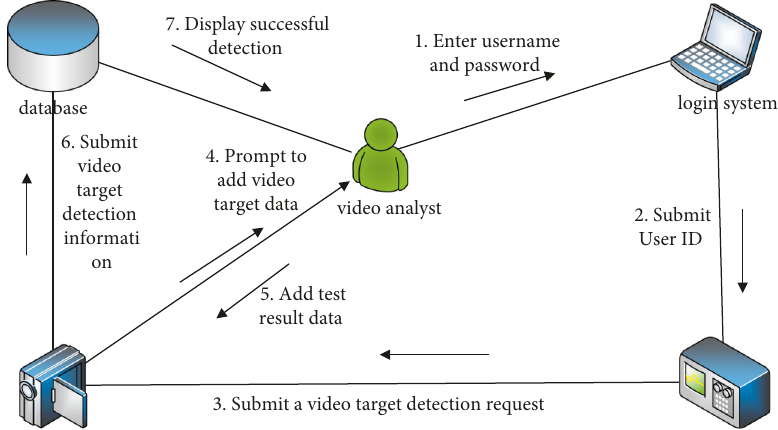
Figure 3: Target tracking management